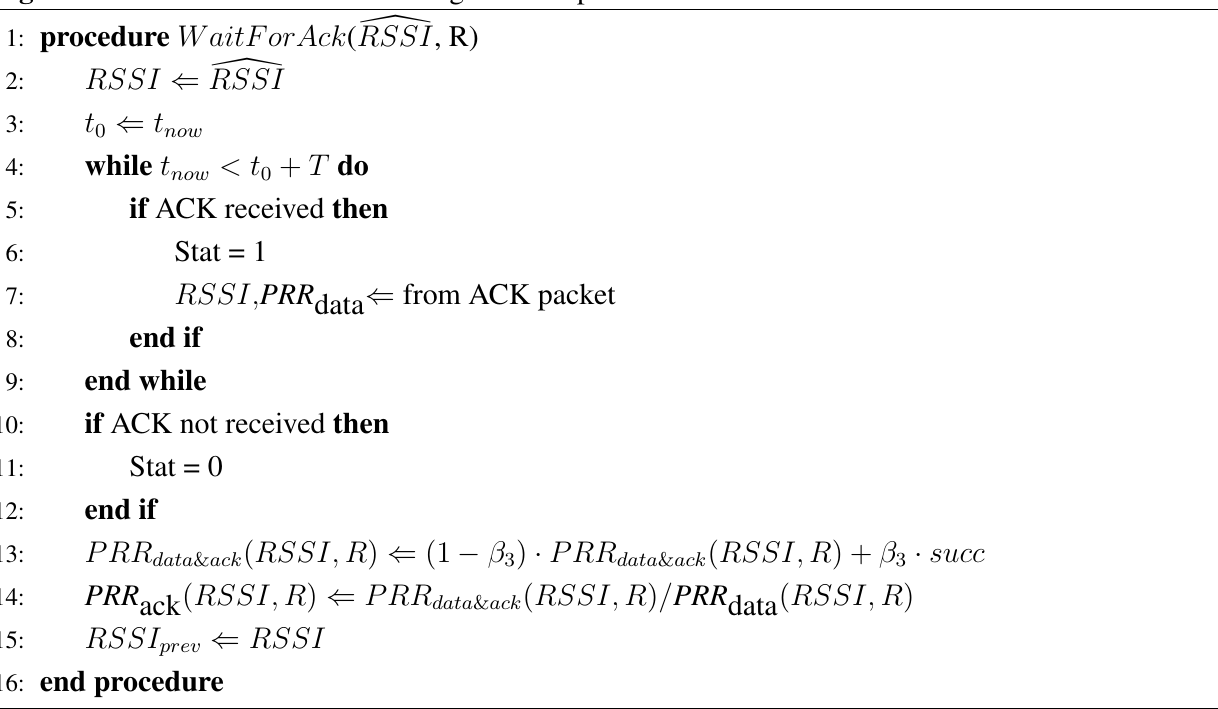
Algorithm 3 Pseudo-code for receiving an ACK